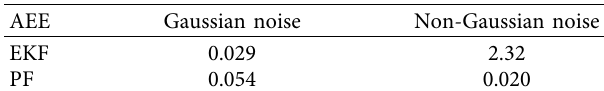
Table 18: AEE for two